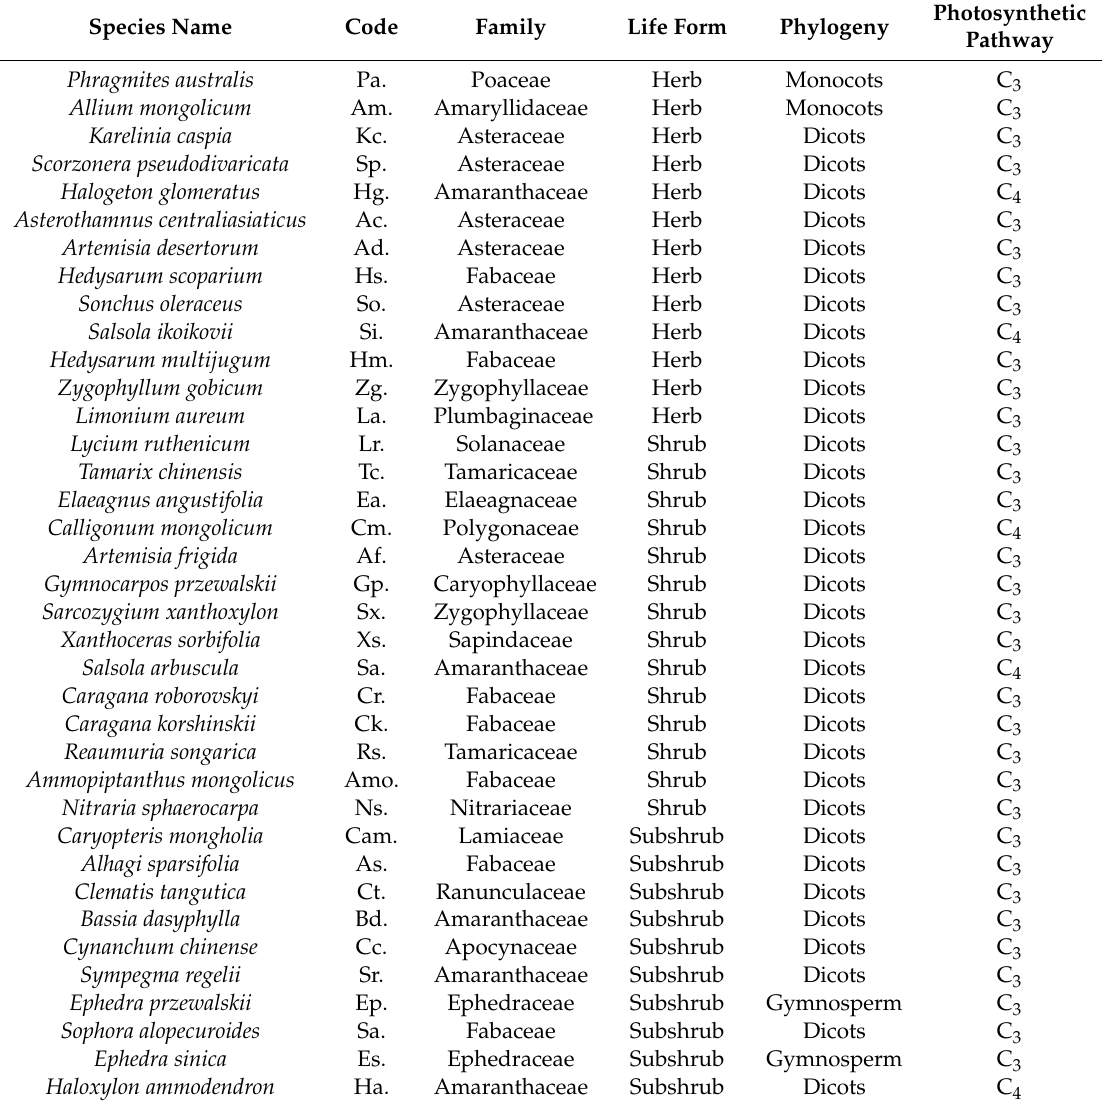
Table 1. Species compositional list of 37 collected plants in di ff erent functional groups in the Guazhou Common